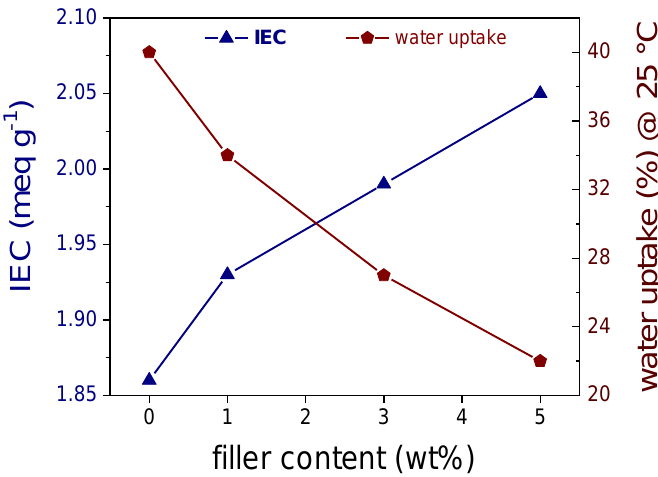
◦ C) with filler loading.